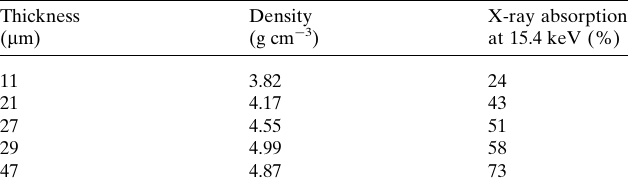
Table 3 Thickness, density and X-ray absorption of the GOS:Tb scintillating screens (the X-ray generator settings are detailed in Section 2.2).